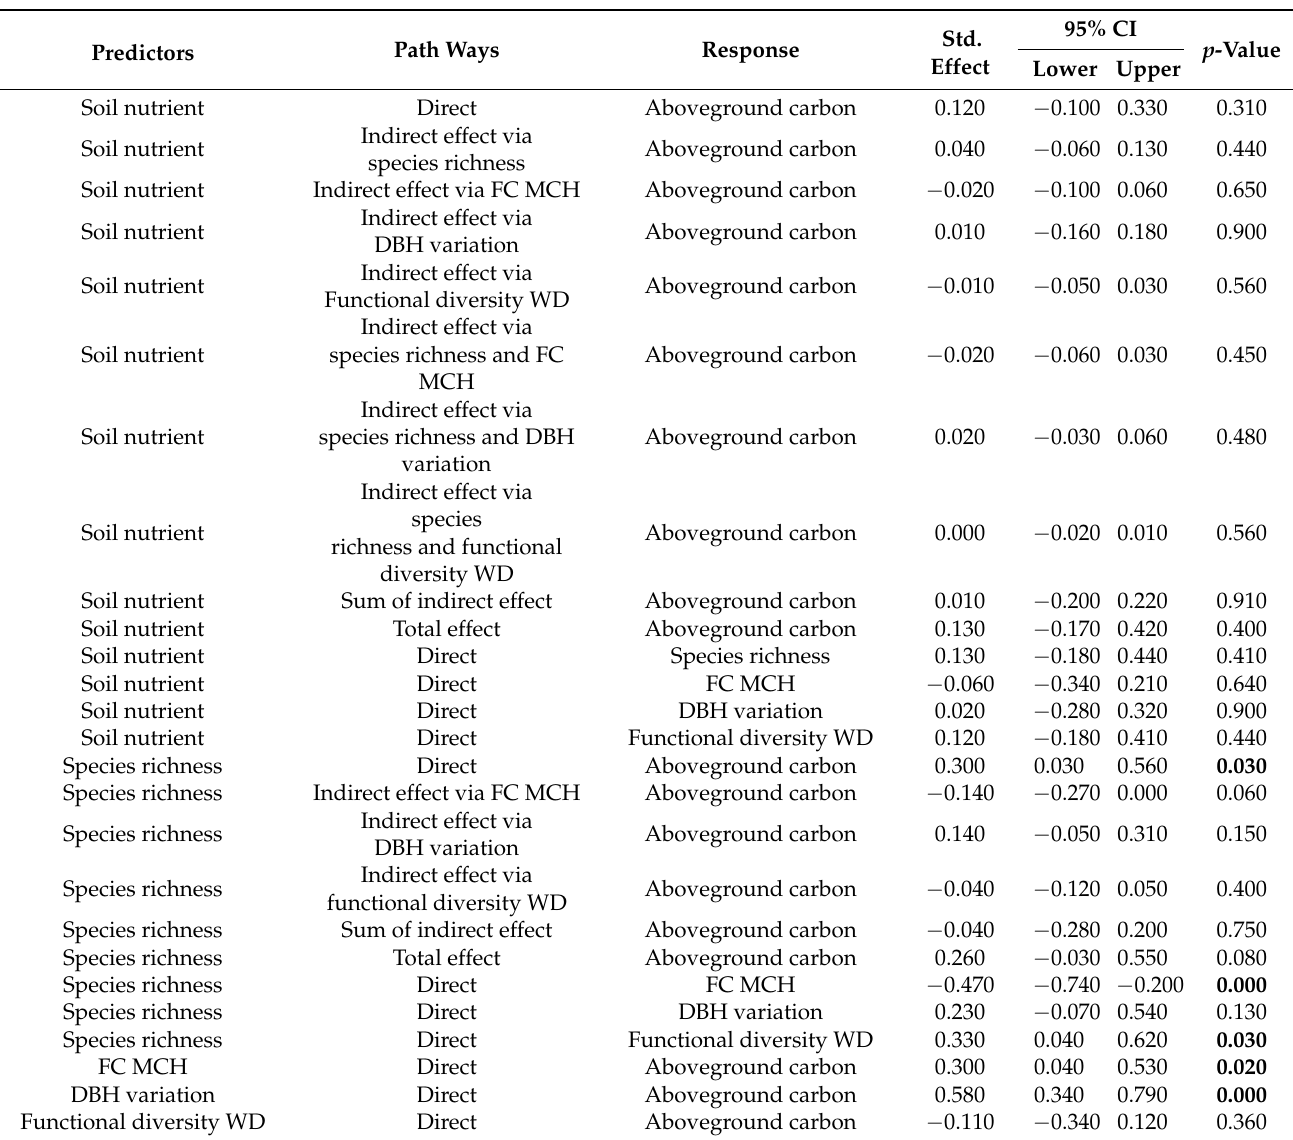
Table 1. Direct, indirect and total standardized effect of soil nutrient and different diversity component on aboveground carbon. p -value in bold indicates significant effect ( p < 0.05), based on 1000 times bootstrapping. DBH: diameter at breast height, FC: functional composition, FD: functional diversity, MCH: maximum canopy height, WD: wood